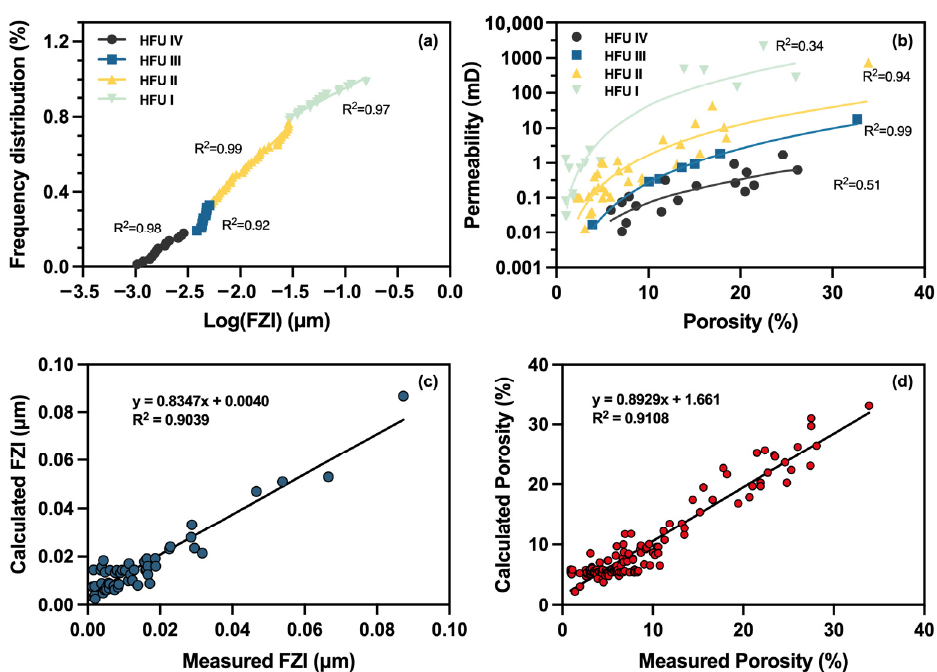
Figure 7. Division of hydraulic flow unit ( a ), relationship of porosity with permeability in each hydraulic flow unit ( b ), verification of calculated FZI and porosity values ( c , d ).